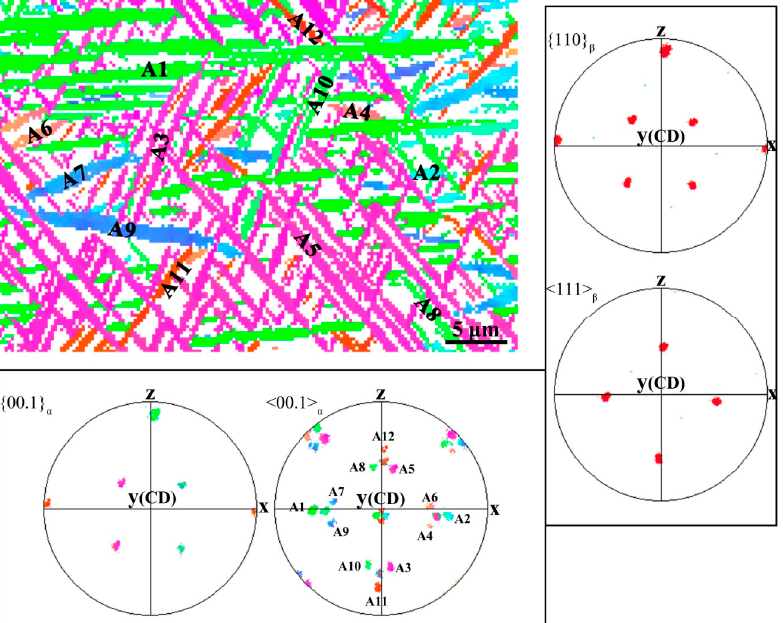
Figure 5. Local pole figure map and the corresponding pole figures in a β grain interior of the sample deformed at 0.2 s − 1 . The compression direction is vertical. All twelve variants are labeled. Note that the Burgers orientation is evident by comparison of the pole